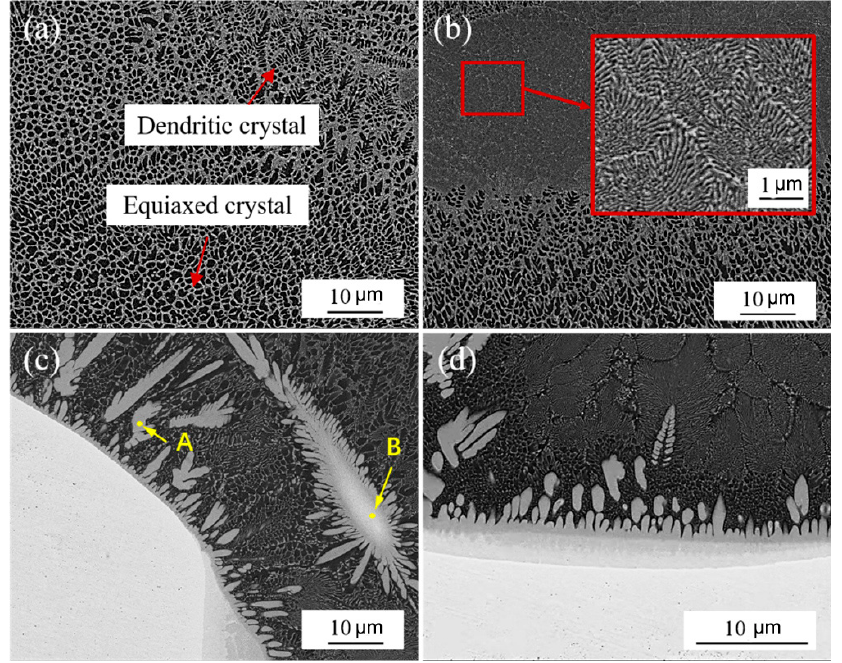
Figure 8. Structure of Ta side weld: ( a , b ) middle structure of weld; ( c ) the structure near the fusion line; ( d ) bottom structure of Ta side weld. Table 7. EDS results for Ta side welds (at.%).